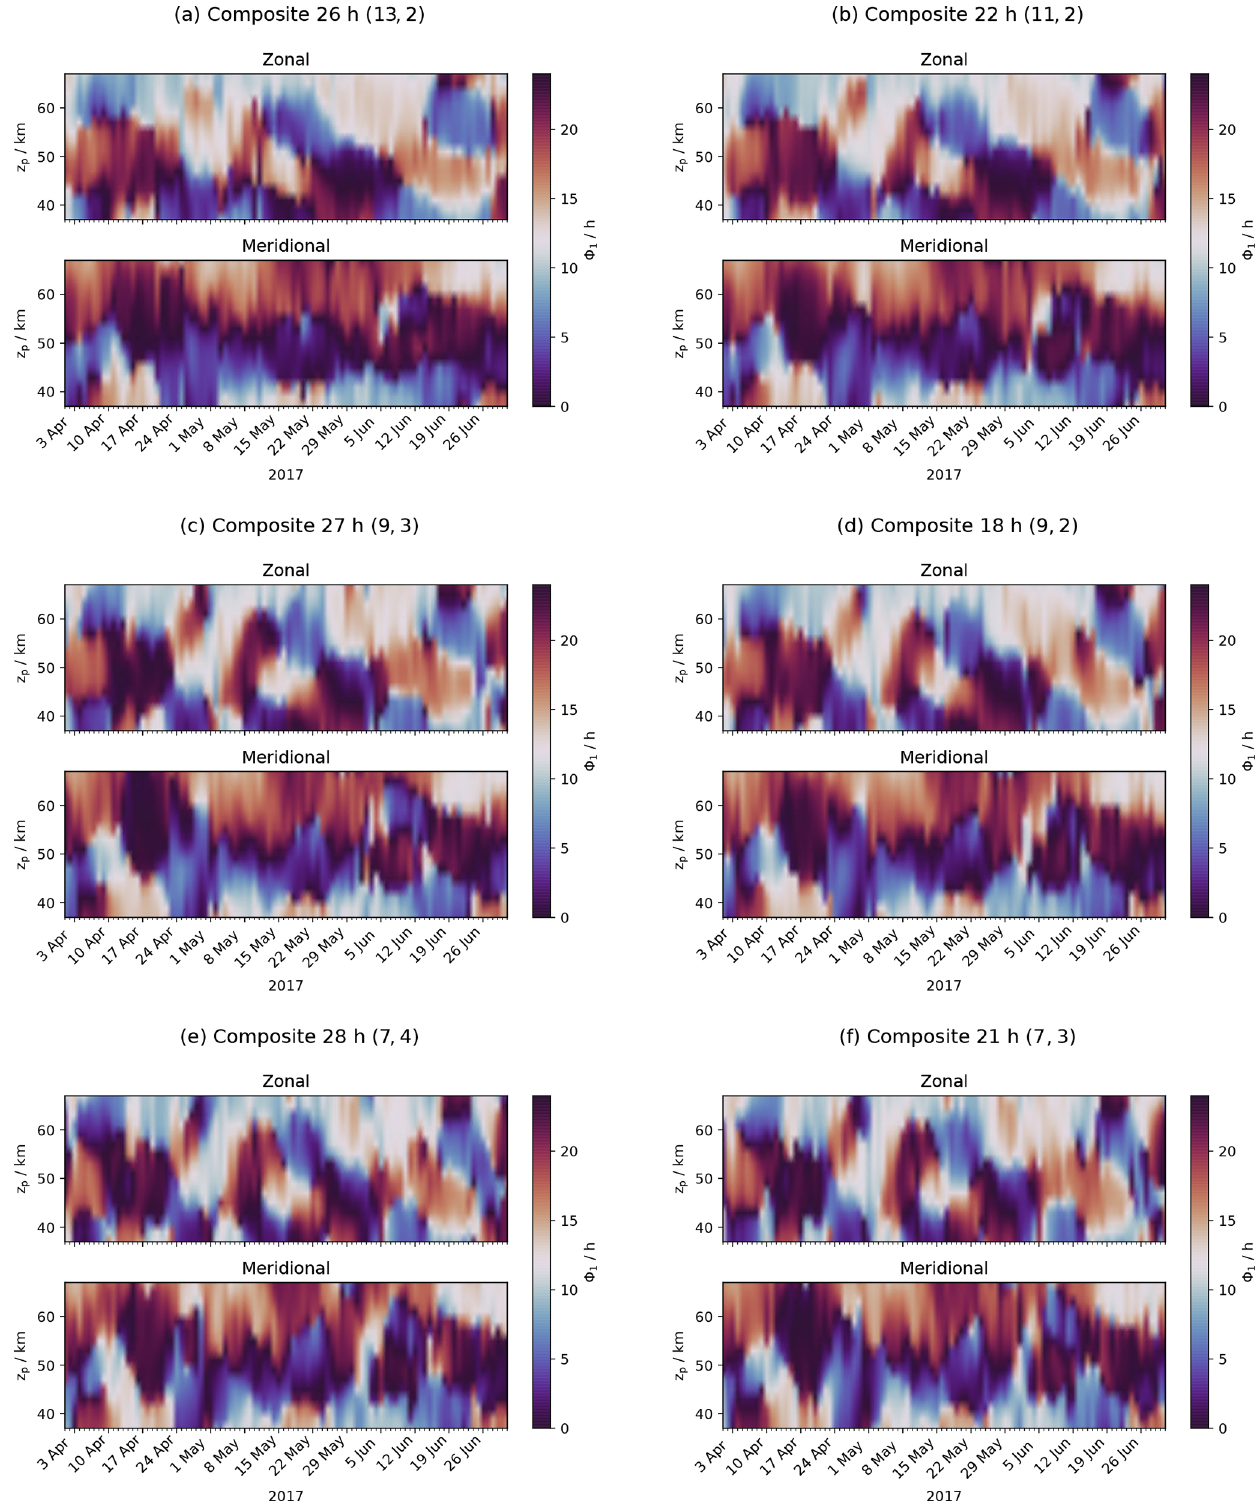
Figure A2. Tropical campaign: phase of the diurnal tide for six different composites with a similar total integration time of 21 to 28h ordered by window